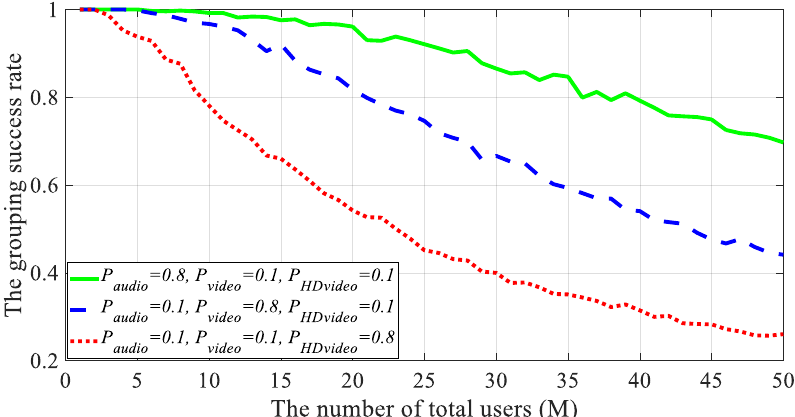
Figure 8. The grouping successful rate of the single relay-allowed modified pilot-based grouping method in scenario 2.